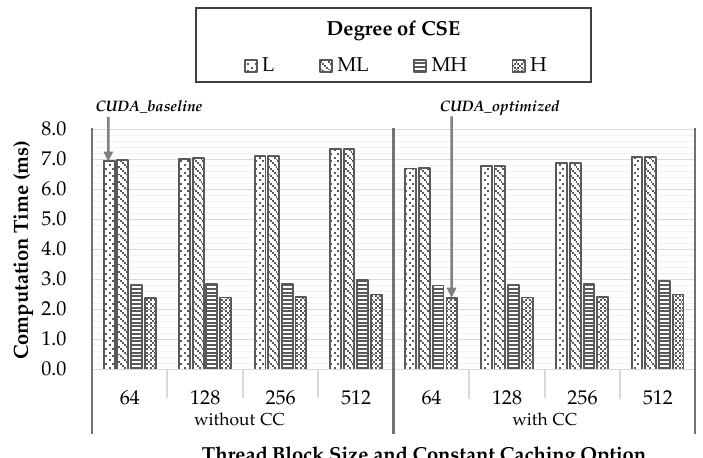
Figure 8. Average objective function computation time of